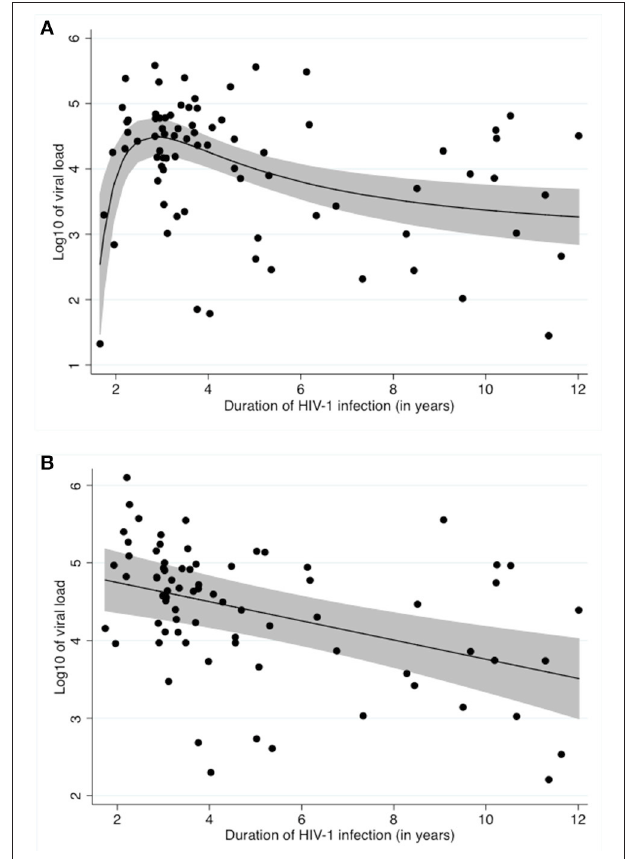
FIGURE 1 | Relationship between log 10 of the viral load and time infected with HIV (A) Unadjusted, (B) Adjusted for Schistosoma status, ln of CAA and CD4 counts. (A) shows the crude relationship between log 10 of viral load and duration of HIV-1 infection. A fractional polynomial was fitted to the data. The black line represents the predicted log 10 of viral load after applying the resulting function to the data. The grey area represents the 95% confidence limits around the fitted values. The black dots represent the residuals. (B) shows the relationship between log 10 of viral load and duration of HIV-1 infection after adjustment for Schistosoma infection status, ln of CAA and CD4 counts using a fractional polynomial. The black line represents the predicted log 10 of viral load after applying the resulting function to the data. The grey area represents the 95% confidence limits around the fitted values. The black dots represent the